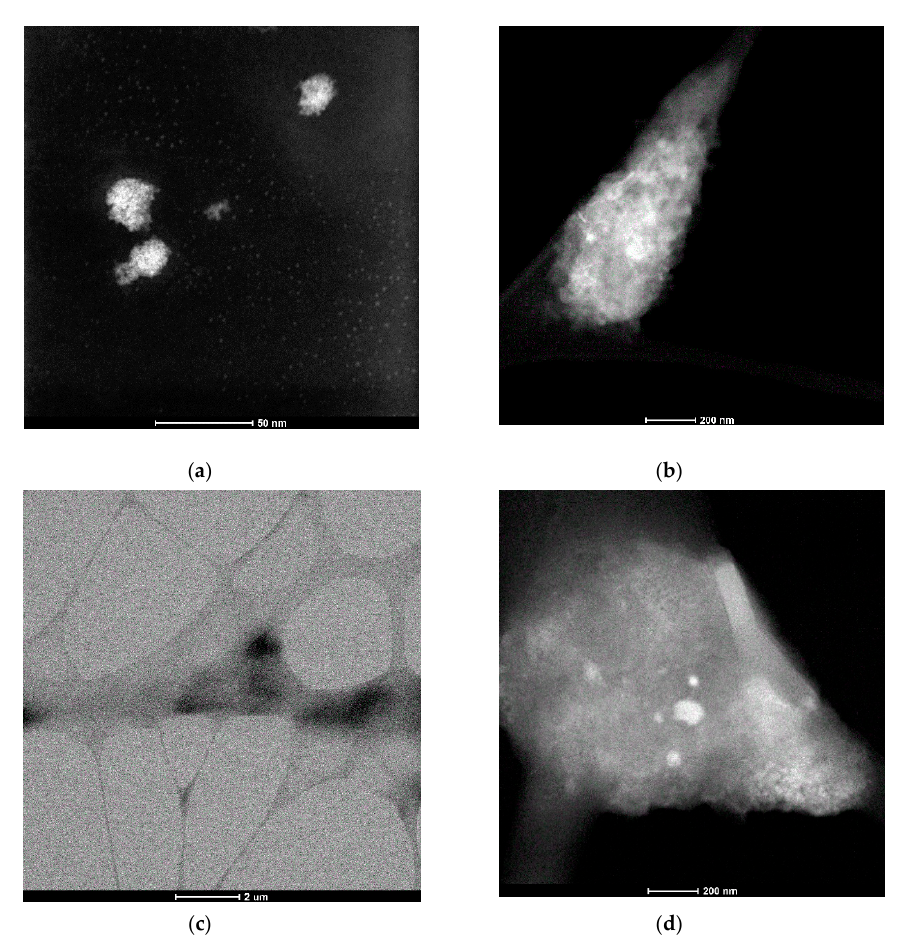
Figure 3. Scanning Transmission Electron Microscopy (STEM) micrographs for aqueous solution of 8-8-8 surfactant ( a ) 0.09 M solution, ( b ) 0.09 M solution after 3 days, ( c ) 0.3 M solution, ( d ) 0.3 M solution—zoom of a region from image ( c